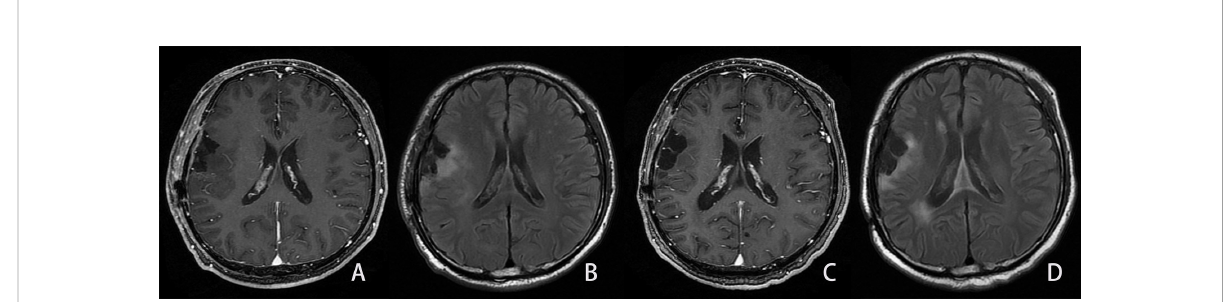
FIGURE 5 Example of the LGG patient in the not-progressed group. Same patient as shown in Figure 2. A man, 54 years old, with diffuse astrocytoma in the right frontal and parietal lobes, and an IDH mutant. The PFS and OS were 1,042 and 1,042 days, respectively. (A, B) . First follow-up MRI